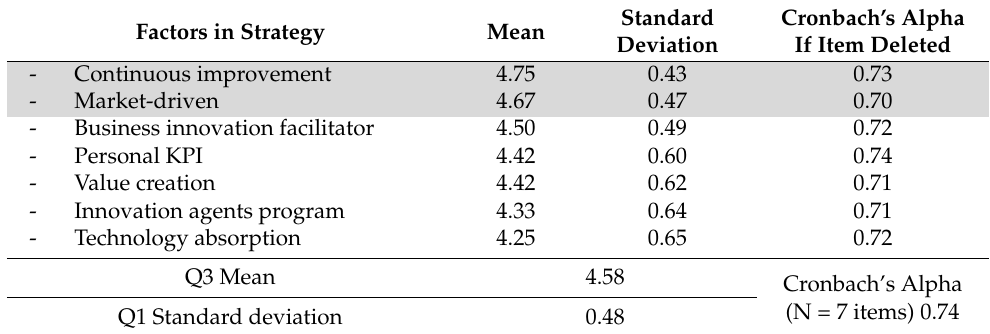
Table 10. Calculation of Q3 mean and Q1 standard deviation of strategy indicator factors.